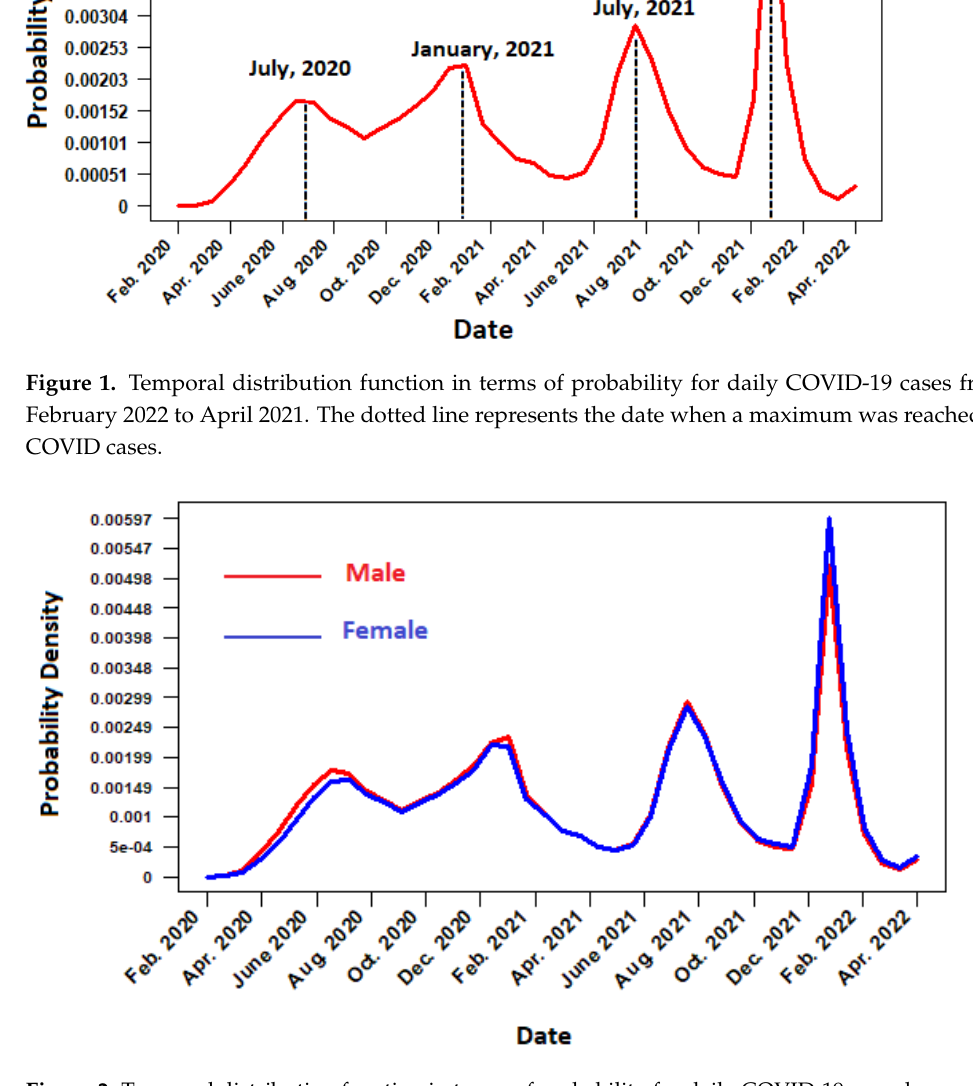
Figure 2. Temporal distribution function in terms of probability for daily COVID-19 cases by